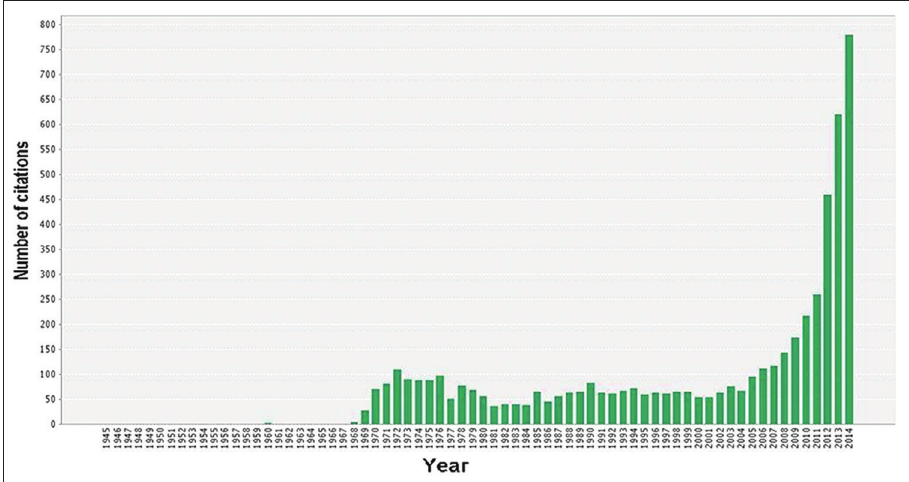
Figure-2: Number of citations to the papers published on m-health topics by year.